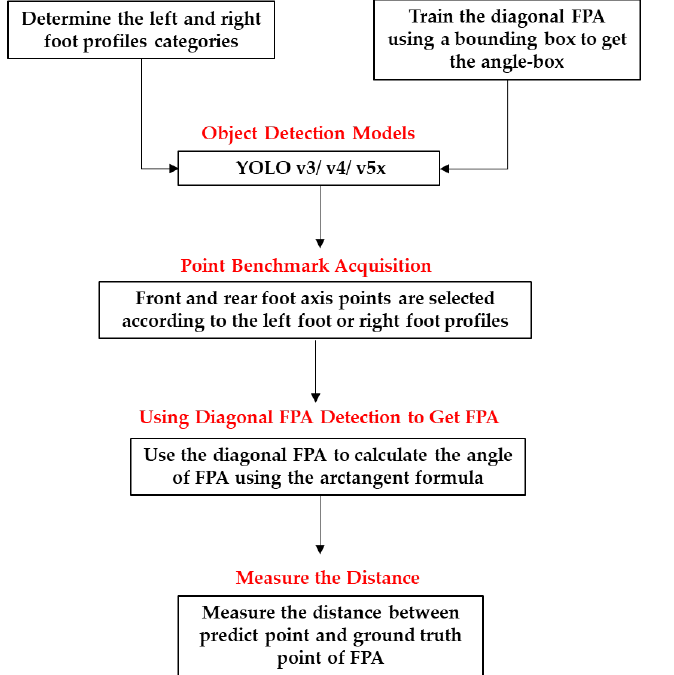
Figure 1. Flowchart illustrating the proposed method of foot progression angle (FPA) detection using YOLOv3, YOLOv4, and YOLOv5x.